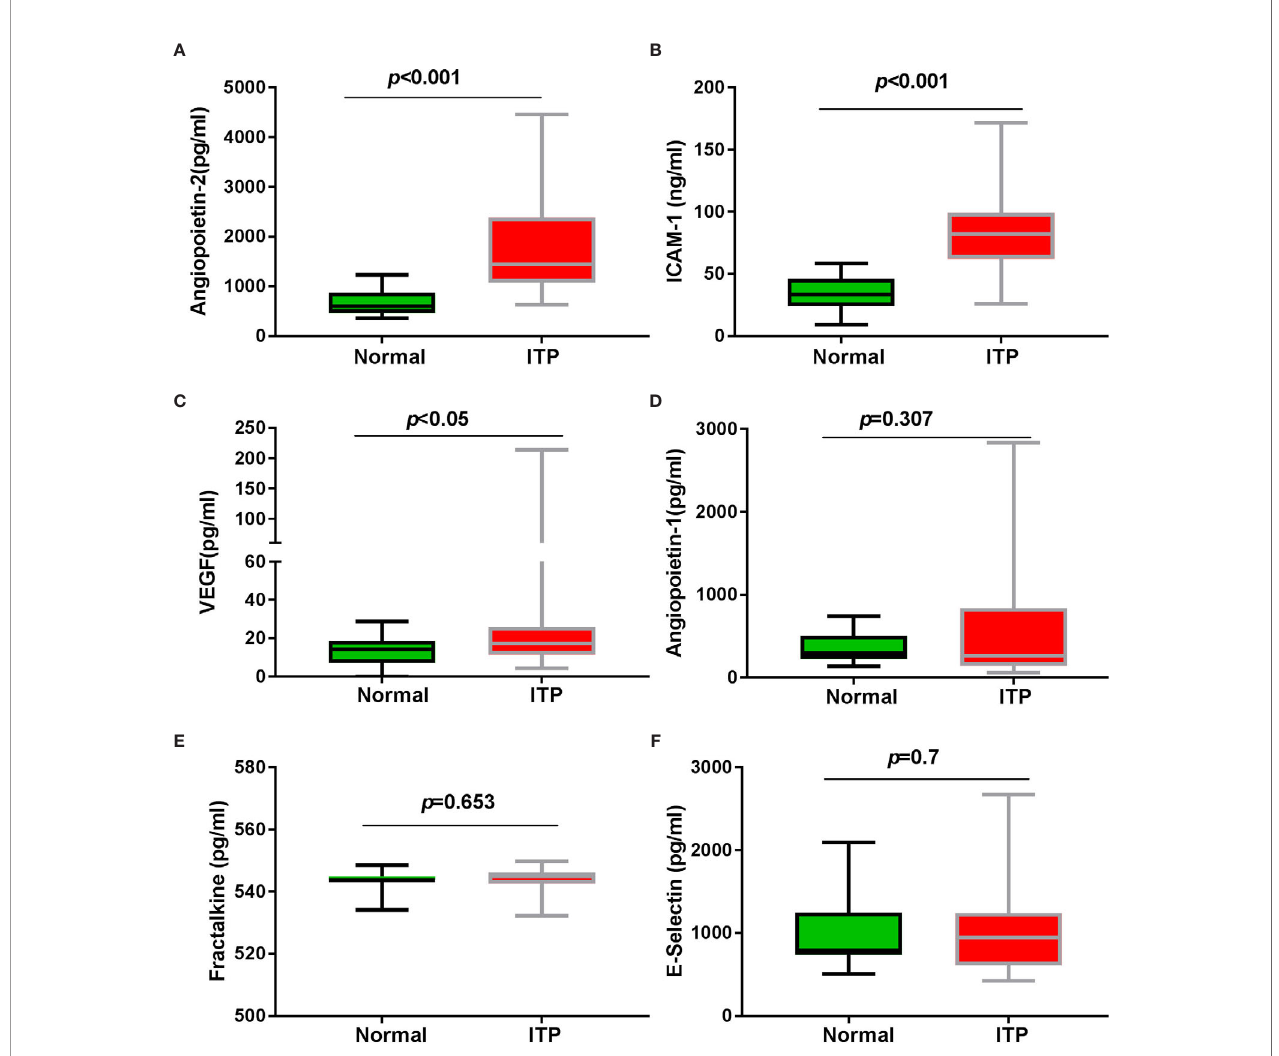
FIGURE 1 | The biomarkers of endothelial activation and vascular integrity. (A) Plasma soluble Angiopoietin-2 concentration, (B) plasma soluble ICAM-1 concentration, and (C) plasma soluble VEGF concentration were signi fi cantly higher in adult corticosteroid resistant ITP patients (n = 88 compared with healthy volunteers n = 30). However, (D) plasma soluble Angiopoietin-1 concentration, (E) plasma soluble Fractalkine concentration, and (F) plasma soluble E-selectin concentration between adult corticosteroid resistant ITP patients and healthy volunteers show no markedly difference. Signi fi cance between these two groups was determined by Student ’ s t-test. Data are expressed as box-whisker plots: the central horizontal line, lower and upper of boxes depict the median, fi rst quartile, and third quartile respectively; and the whisker extends to the minimal and maximal data